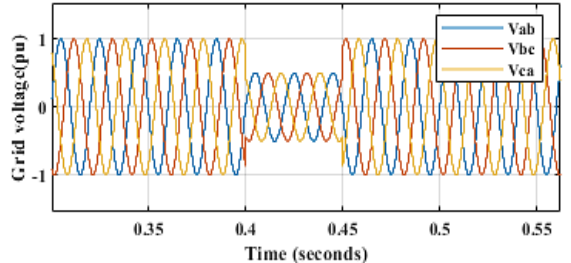
Figure 12. Grid voltage of the DFIG system under scenario I.